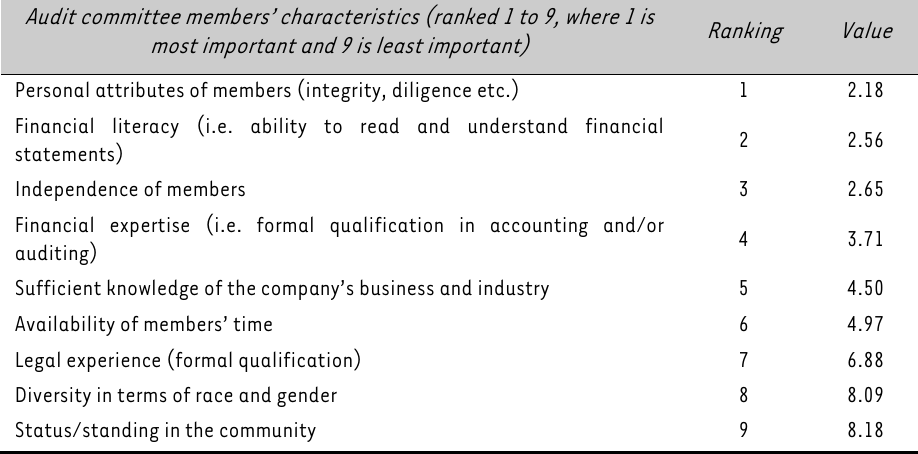
TABLE 3: Audit committee member